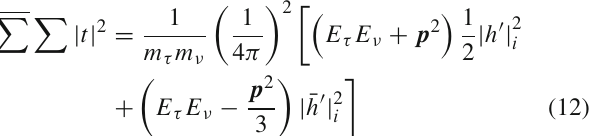
Table 4 Couplings of the I = 1, G = − 1, axial-vector resonance a 1 ( 1260 ) to the different V P channels